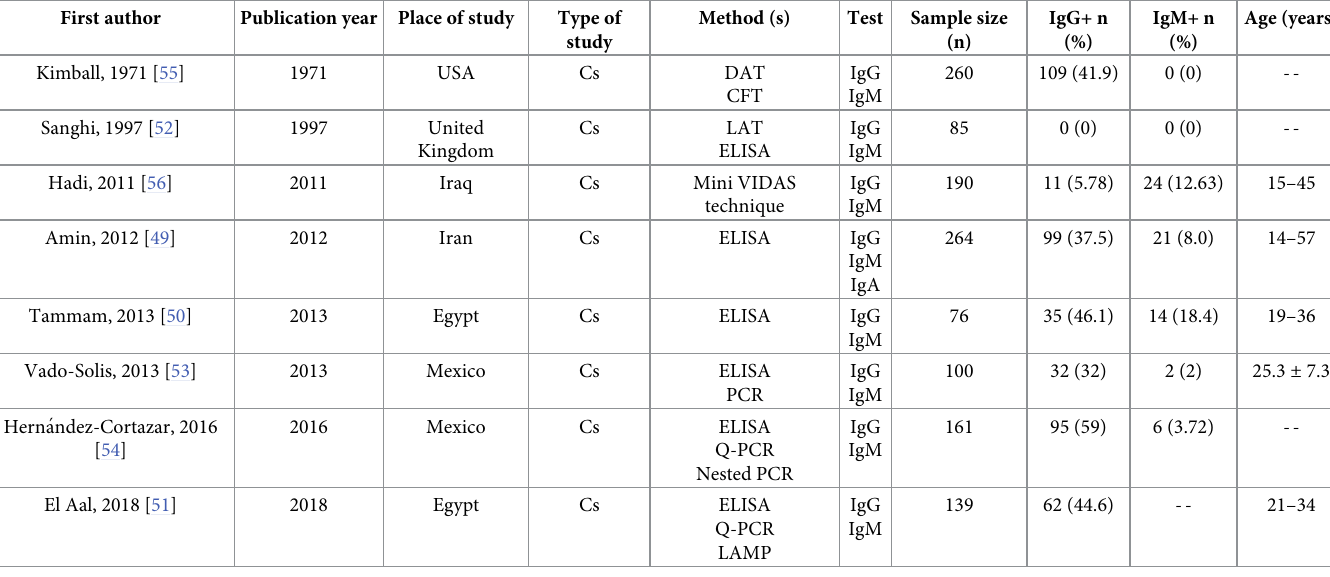
Table 2. Characteristics of the included studies for seroprevalence of anti- T . gondii antibodies in women who had abortion in present